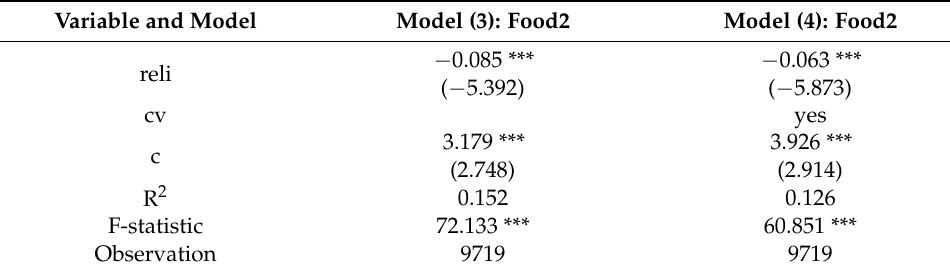
Table 4. Results of robustness